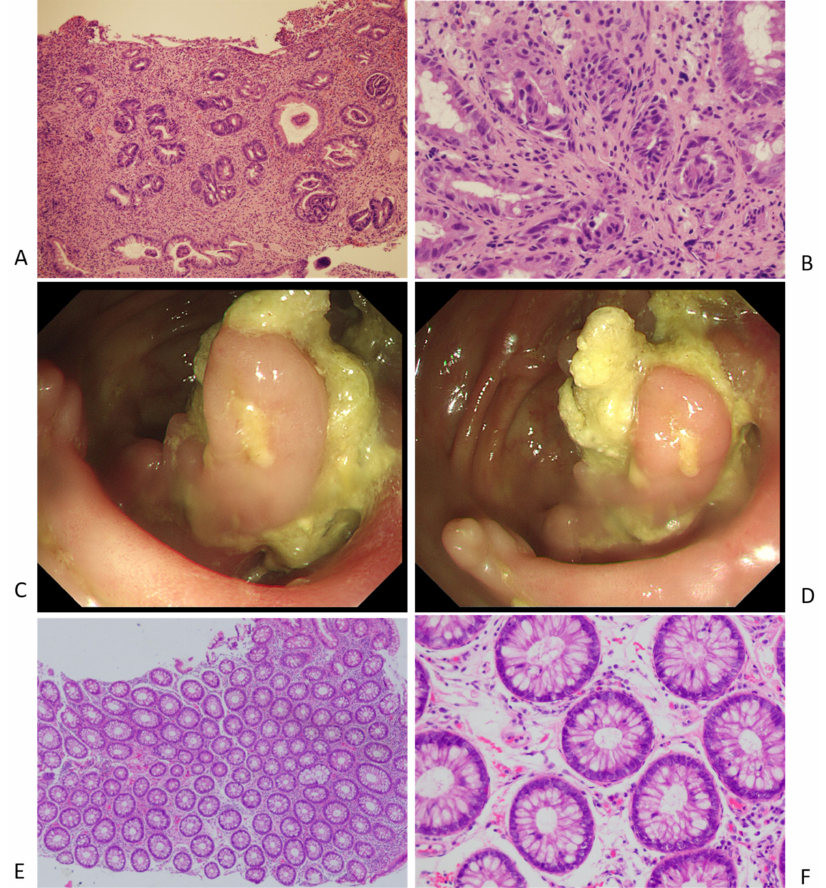
Figure 2. ( A , B ) The pre-treatment pathology results of ileocecal ulcer. ( C , D ) The post-treatment endoscopy images of ileocecal region. ( E , F ) The post-treatment pathology results of ileocecal